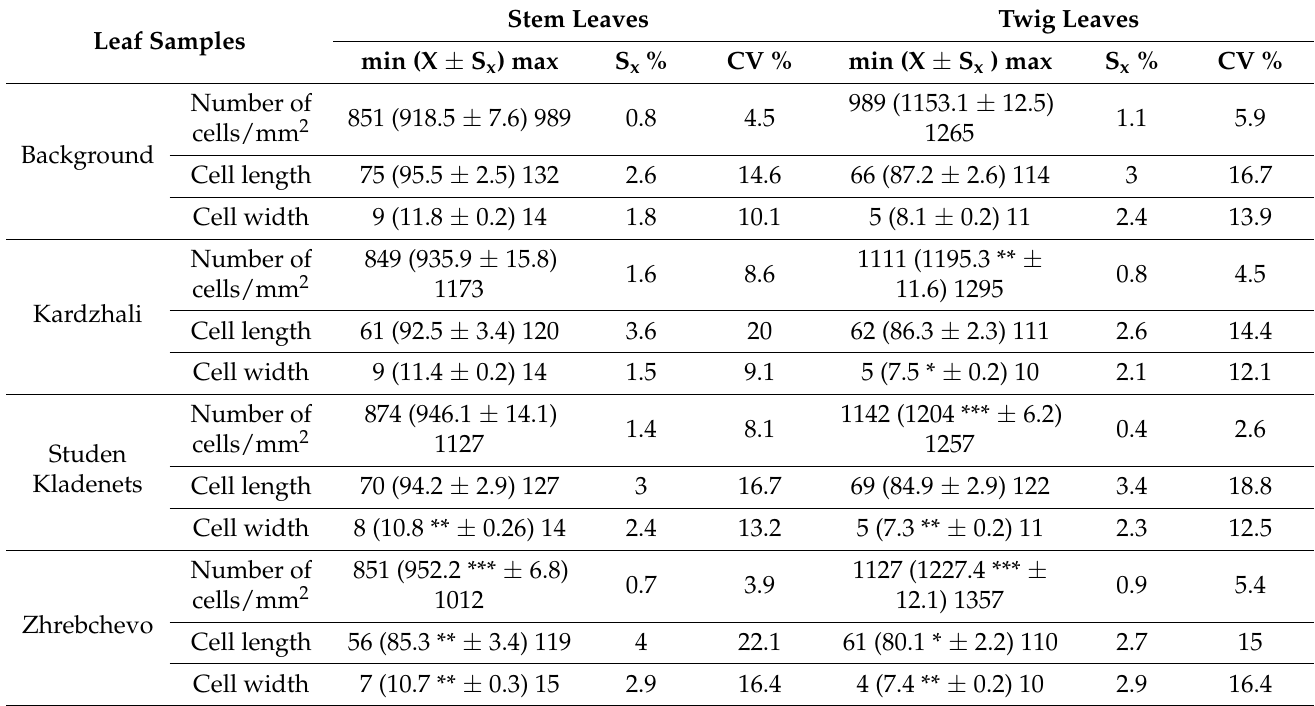
Table 2. Micromorphological cell characteristics of Fontinalis antipyretica . Legend: X—arithmetic mean; min—minimum; max—maximum value; S x— arithmetic mean error; CV—coefficient of variation; cell length and width are given in µ m; level of significance: * p ≤ 0.05; ** p ≤ 0.01; *** p ≤